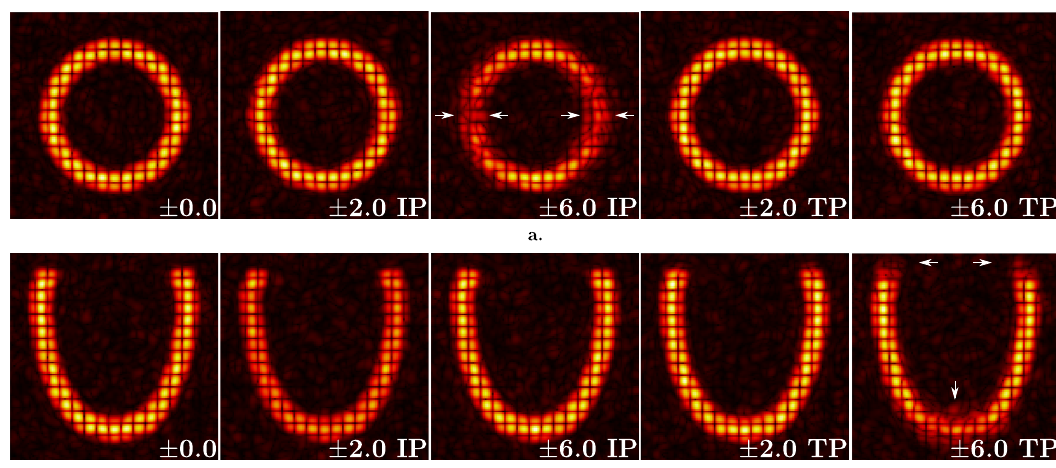
Fig 3. Anisotropically resolved synthetic images to analyze the effect of geometrical inconsistencies. Images with 7 mm tag distance, SNR 20, and 3.5x7.0x7.0 mm 3 pixel size for varying amounts of shift increasing from left to right (values are written at the bottom right corner for each case) on short-axis (a) and long-axis (b) views. IP and TP stand for the direction of shift, in-plane and through-plane, respectively. Images represent the configuration at end-diastolic time frame. The arrows indicate the regions with the largest amount of error due to shift for IP ( ± 6 IP) and TP ( ± 6